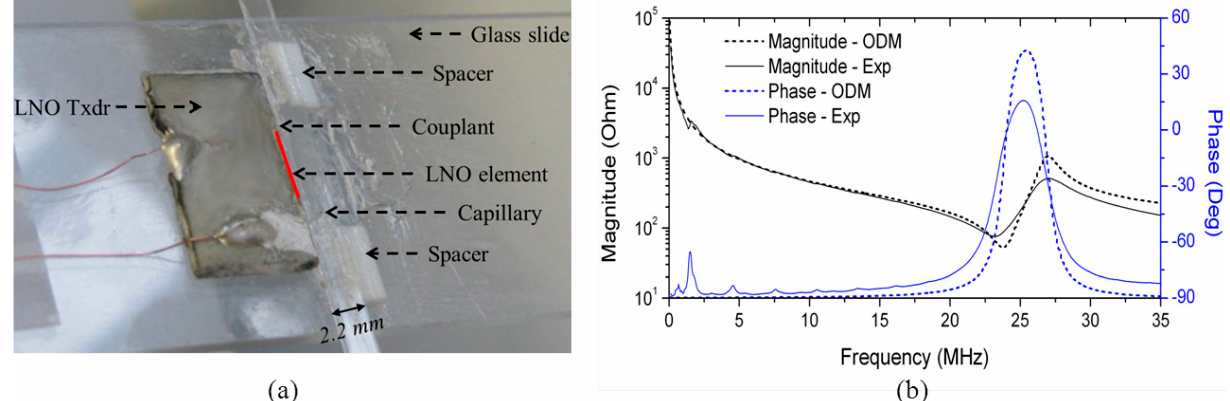
Figure 13. ( a ) Planar ultrasonic resonator; ( b ) the experimental electrical impedance spectrum of the transducer compared to the ODM modelled electrical impedance spectrum of the LNO element.